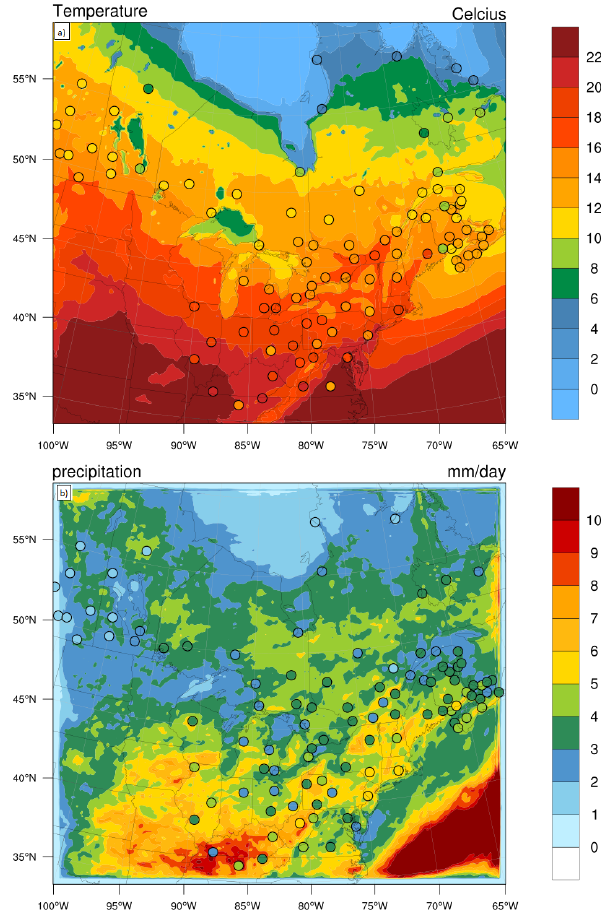
Figure 1. Observed and simulated 2m temperature (a) and total daily precipitation (b) averaged for five months (April– August 2009). Measurements are shown as circles with the same colour scale as the